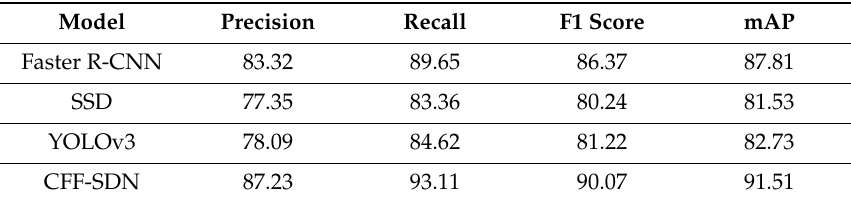
Table 4. The precision, recall, F1 score and the mean of average precision (mAP) of different models for ship detection in optical remote sensing images.